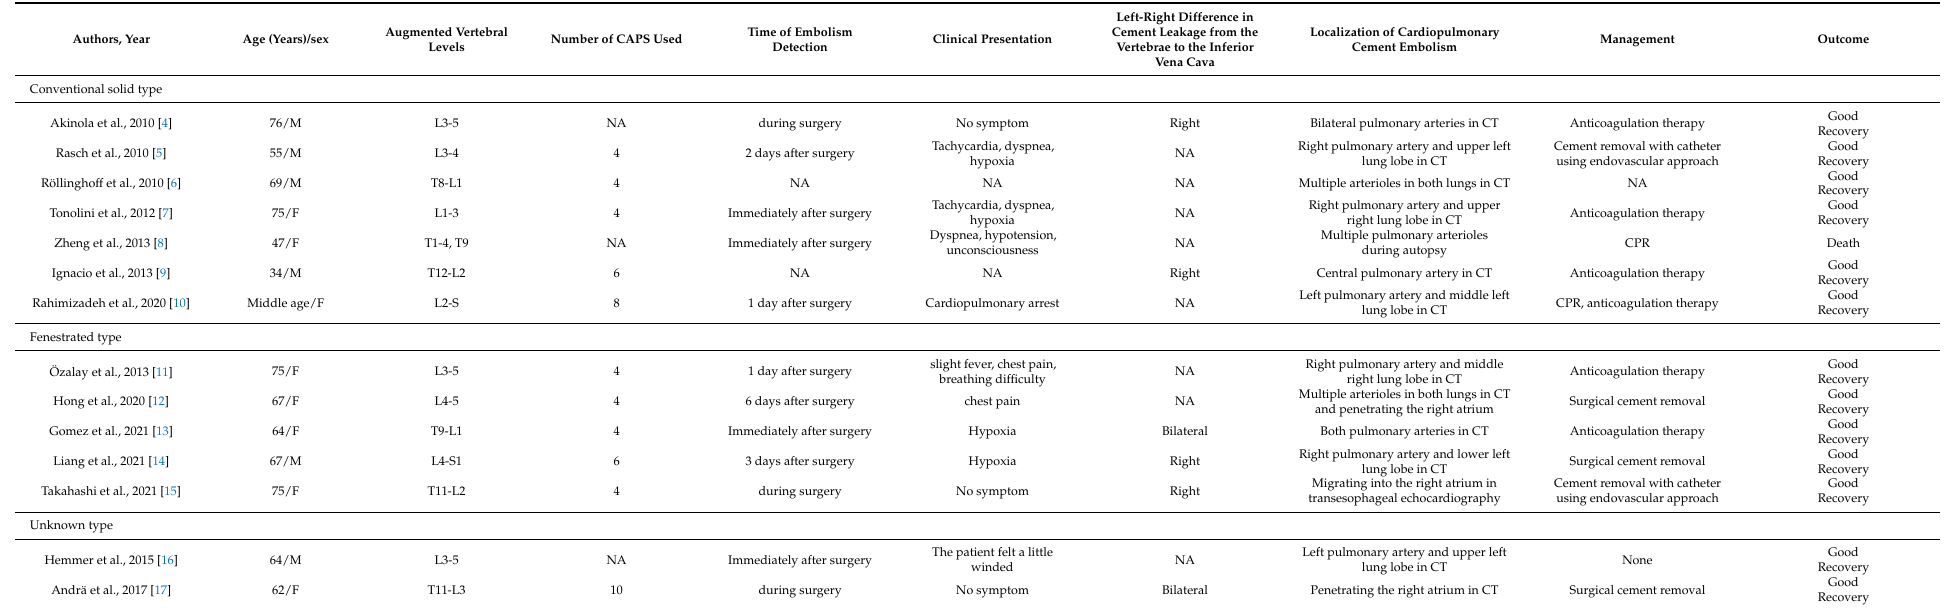
Table 2. Summary of reported cardiopulmonary embolism caused by cement-augmented pedicle